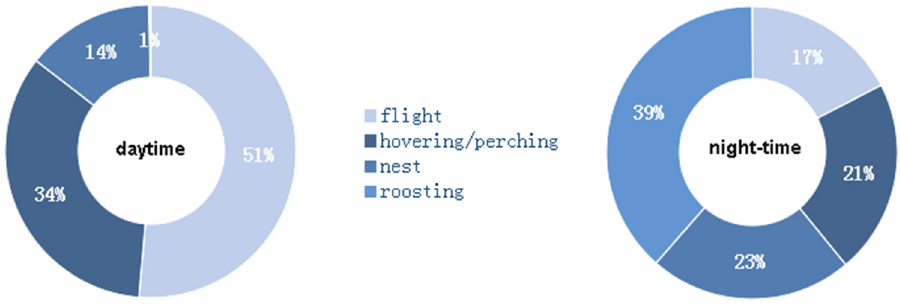
Figure 5. Ethograms of the tracked red-footed falcons for ( left ) daytime and ( right ) night-time.